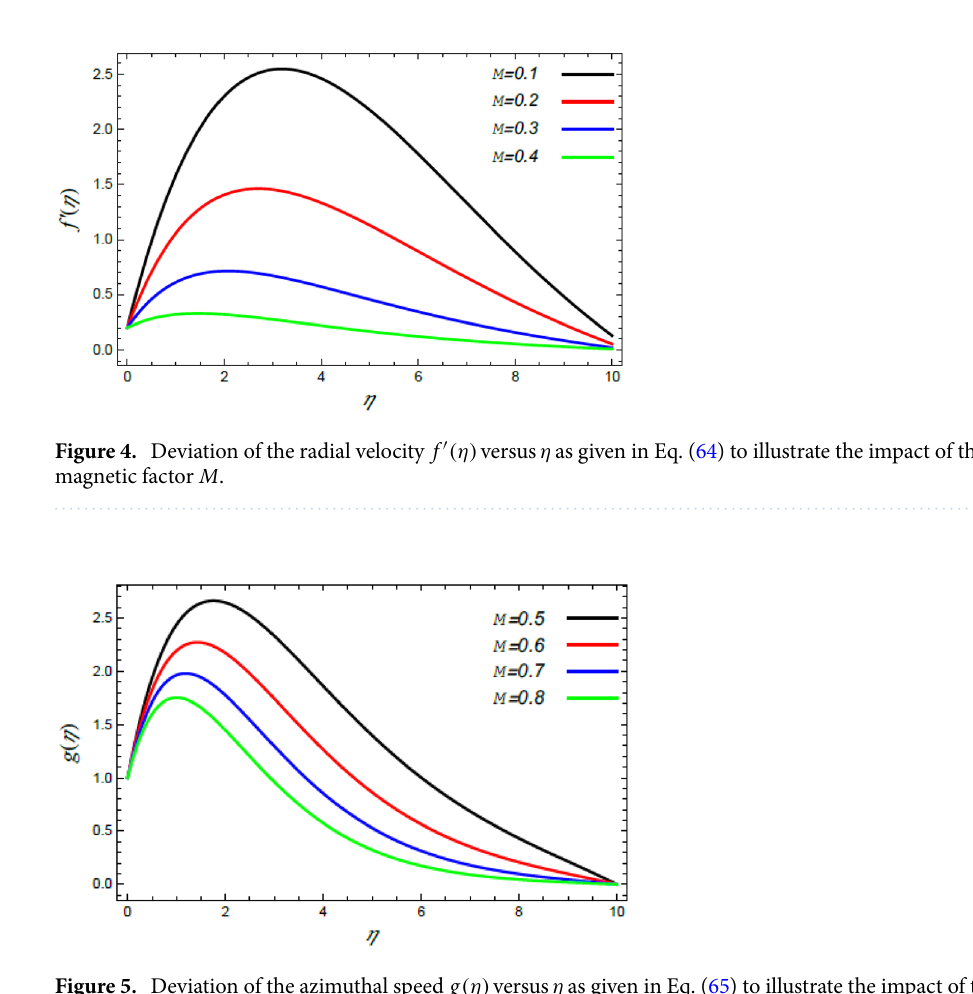
Figure 5. Deviation of the azimuthal speed g (η) versus η as given in Eq. (65) to illustrate the impact of the magnetic factor M